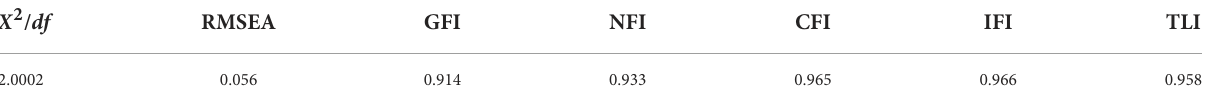
TABLE 4 Construct validity.